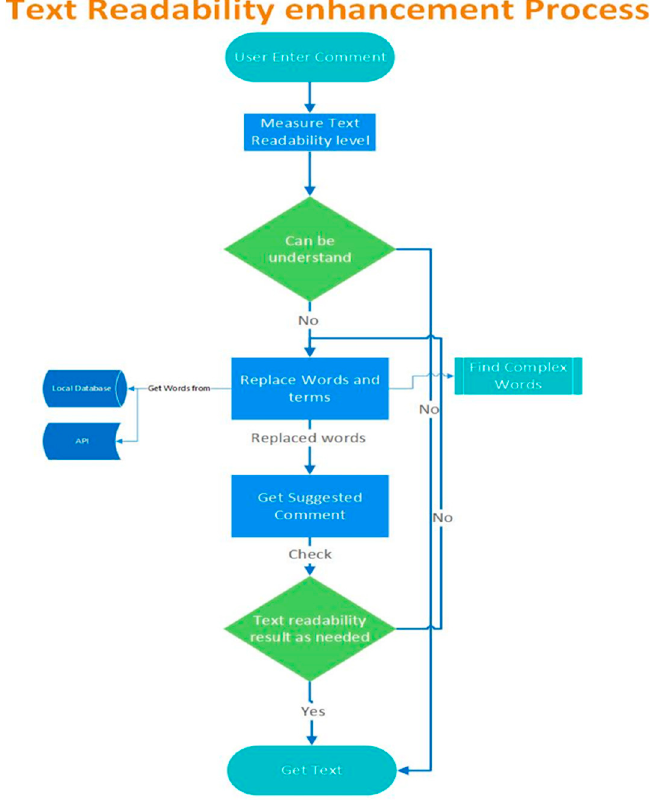
Figure 3. Overall system process.